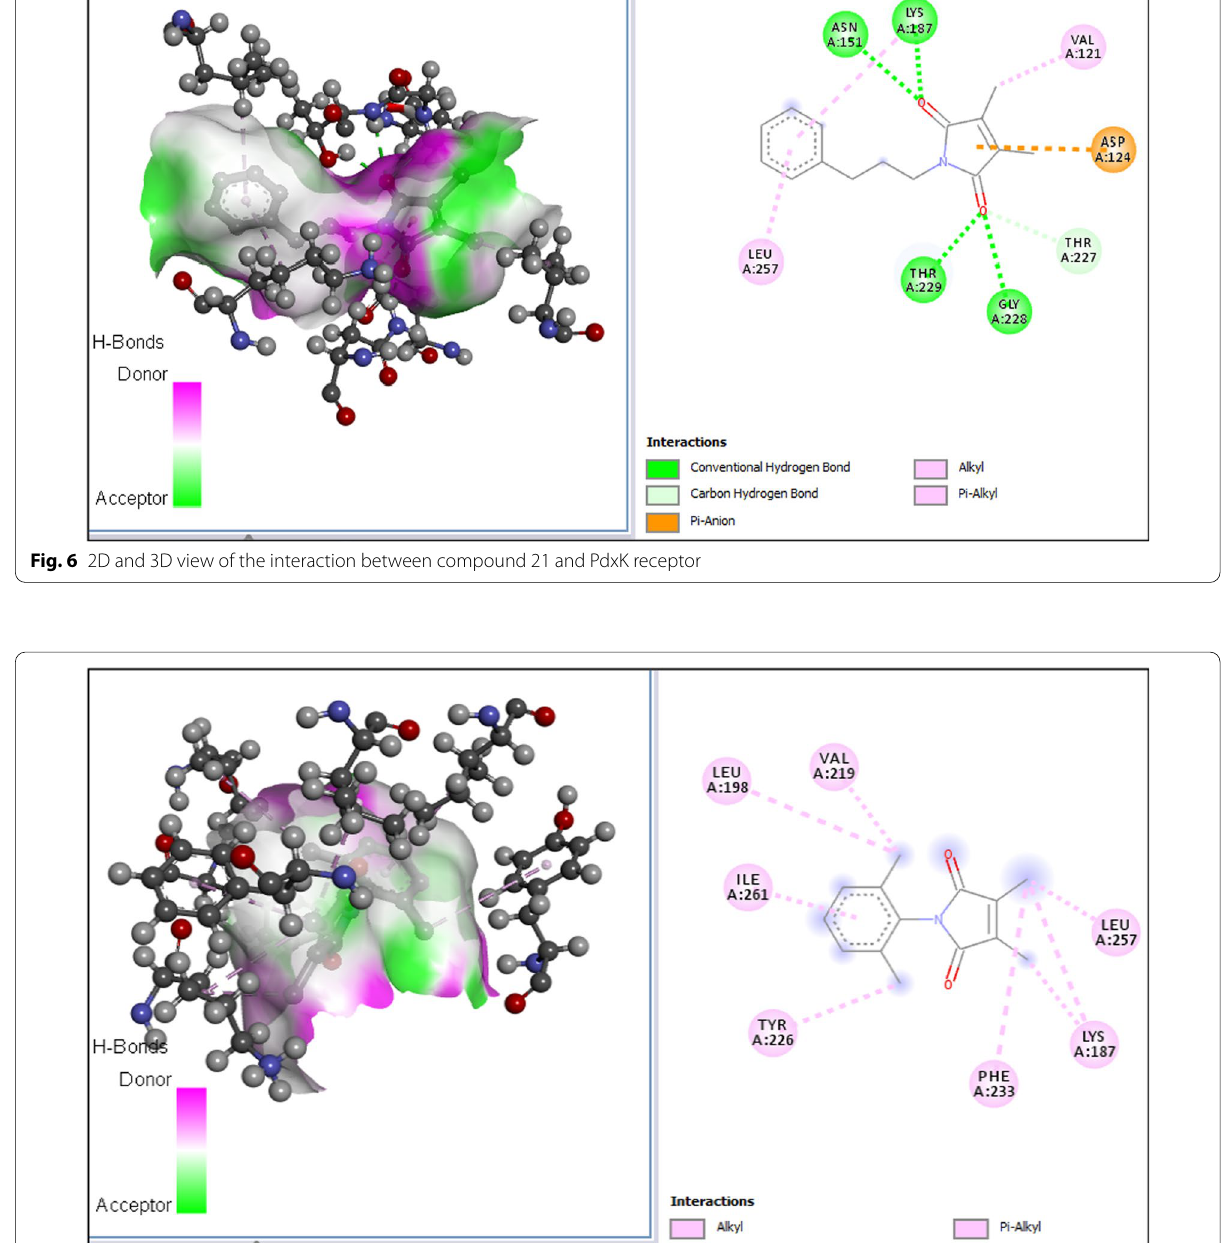
Fig. 7 2D and 3D view of the interaction between compound 24 and PdxK